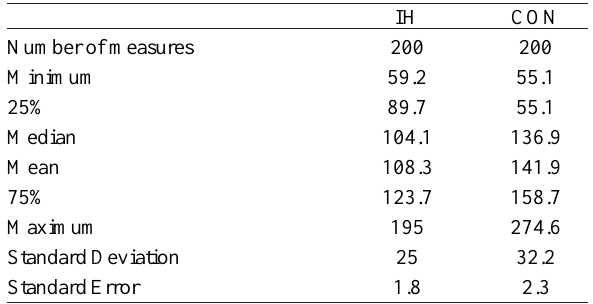
Table 1. Statistical analysis of cardiomyocyte nuclear size of induced hypothermic and control